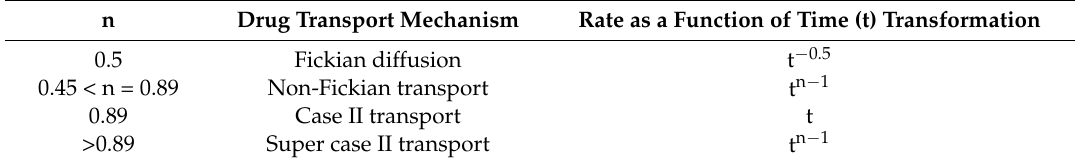
Table 2. The variability of release exponent (n) and the respective release